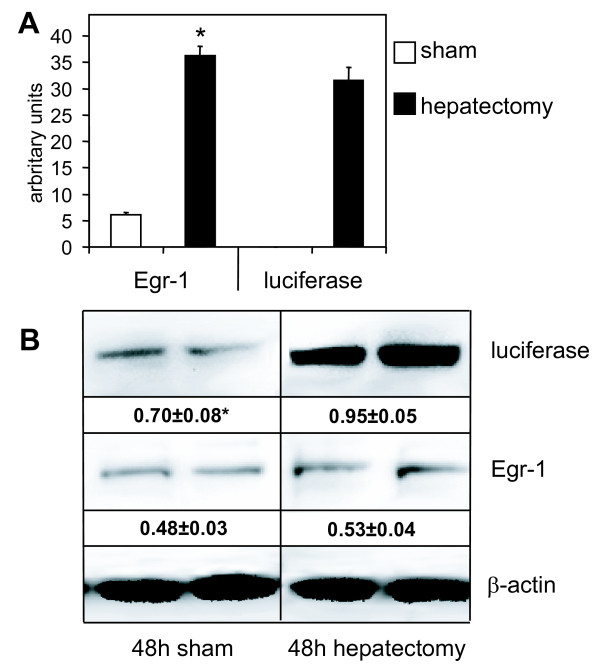
mRNA and protein levels of Egr-1 and luciferase after partial hepatectomy. Egr-1-luc mice were subjected to one third hepatectomy or sham operation, sacrificed 12 h (A) or 48 h (B) after surgery and liver tissue subjected to mRNA analyses by qRT-PCR (A) or Western blot analyzing protein levels of Egr-1 and luciferase (B).
A: mRNA levels of Egr-1 and luciferase, respectively (average relative mRNA levels relative to 18S rRNA levels); mRNA levels of luciferase in sham operated animals were below the detection limit. n = 4, mean values + standard deviation are shown; *p < 0.05 sham vs. hepatectomy (U-test, Mann-Whitney). B: Representative Western blots showing the protein levels of Egr-1, luciferase and β-actin for sham operated (left panel) or hepatectomized animals (right panel), respectively; data from two representative animals per treatment are shown. Numbers indicate relative luciferase and Egr-1 expression calculated from optical densities (OD) of luciferase, Egr-1 and ß-actin protein bands. n = 4, mean values + standard deviation are shown; *p < 0.05 sham vs. hepatectomy (U-test, Mann-Whitney).